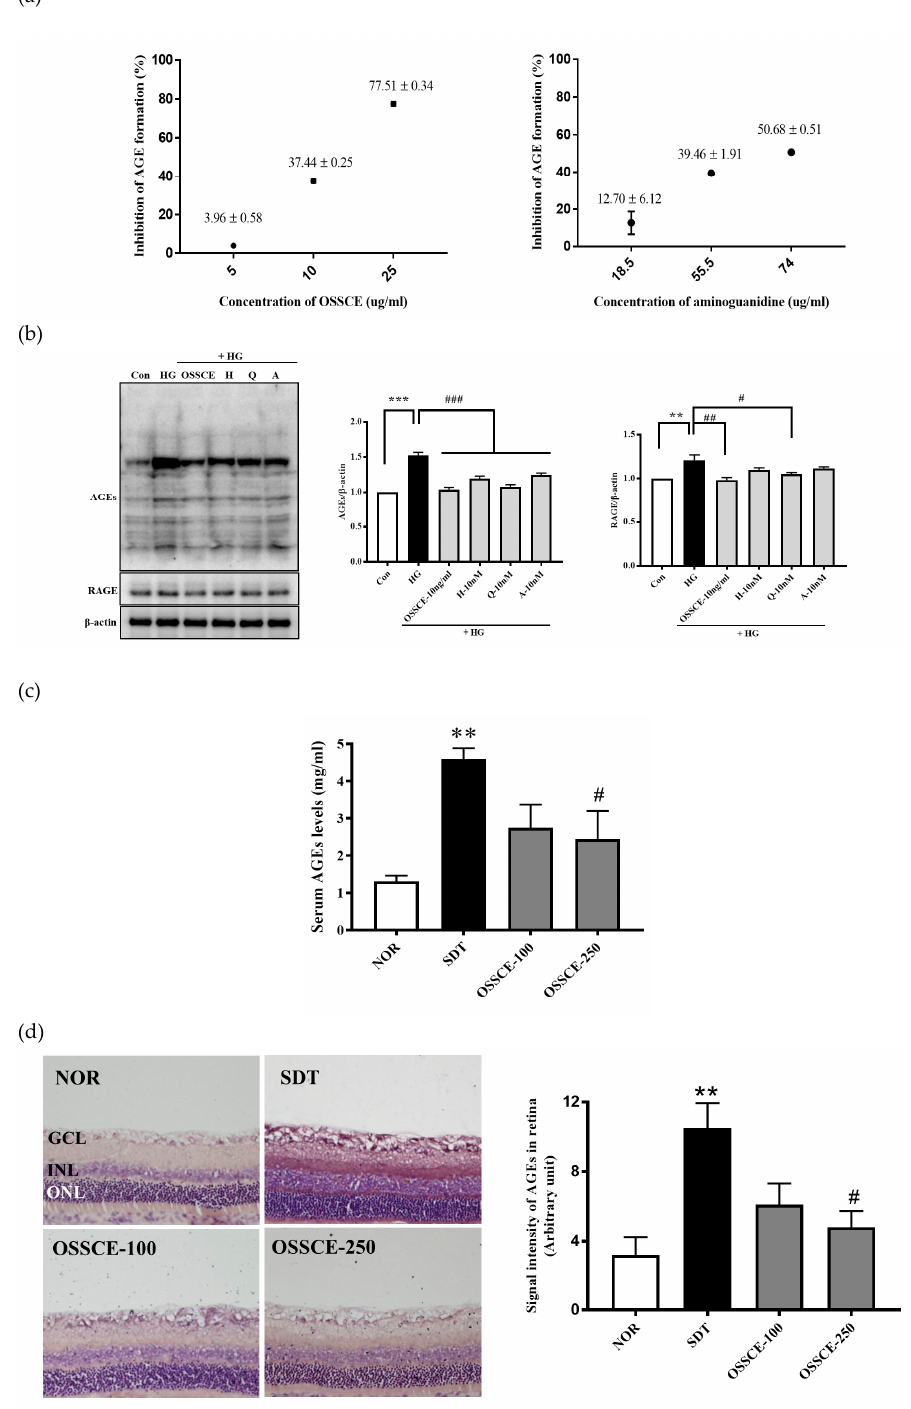
Figure 2. OSSCE inhibits AGE formation and RAGE expression. ( a ) The inhibitory action of OSSCE on nonenzymatic AGE formation: Aminoguanidine (AG) was used as a positive control. OSSCE was